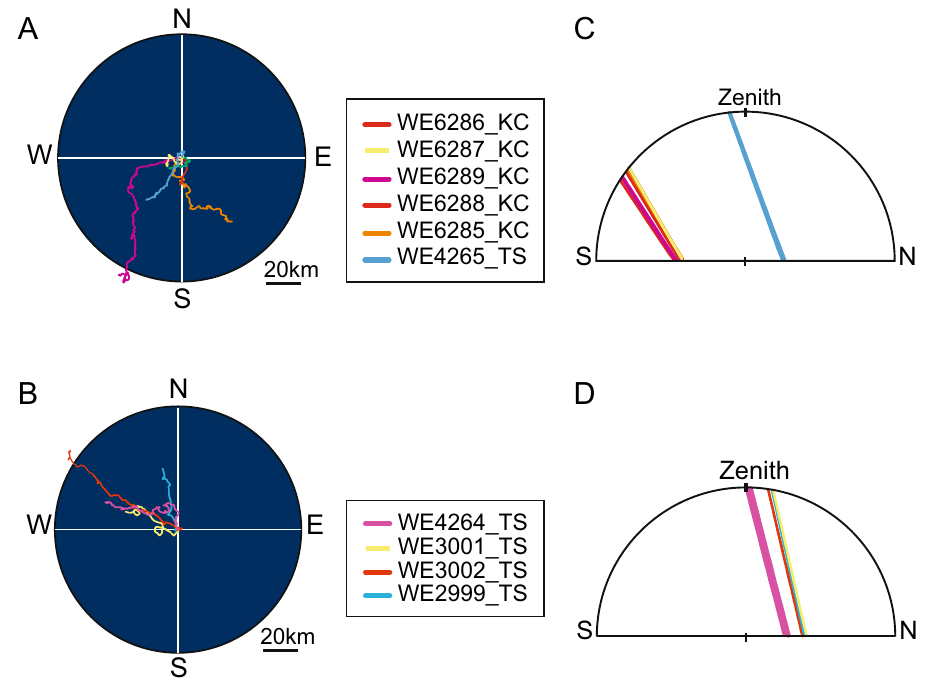
Figure 6. Swimming trajectories of eels and solar paths in the celestial sphere viewed from east during each tracking period. Swimming trajectories of eels released at ( A ) 20°N in the tropical–subtropical area and the Kuroshio Current area, and ( B ) 12°–14°15 ′ N in the tropical–subtropical area. Solar paths through the north (N)–south (S) axis and the zenith at the time of tracking in ( C ) 20°N in the tropical–subtropical area and the Kuroshio Current area, and ( D ) 12°–14°15 ′ N in the tropical–subtropical